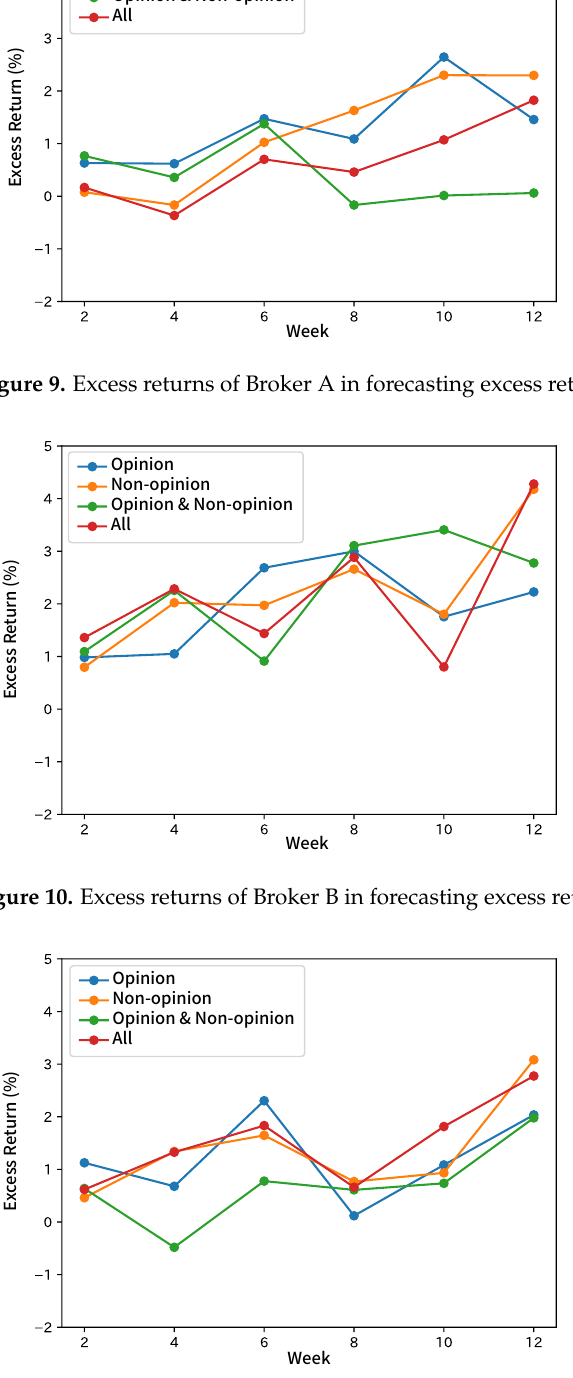
Figure 11. Excess returns of Broker C in forecasting excess